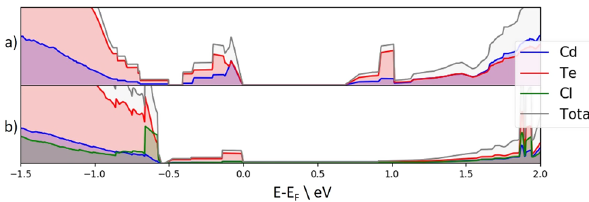
Fig. 8 Normalised DOS grain boundary structure with varying Cl concentration. Normalised DOS plot of a the clean Σ 3 (112) grain boundary structure containing a stacking fault layer and b Σ 3 (112) grain boundary structure containing 14 Cl without a stacking fault. A detailed study of the chlorine passivation and DOS plots of the clean GB with and without Cl stacking faults can be found in reference 8 . Comparing the DOS plots, it is clear that there is minimal effect from the stacking faults, especially in the mid-gap DOS.